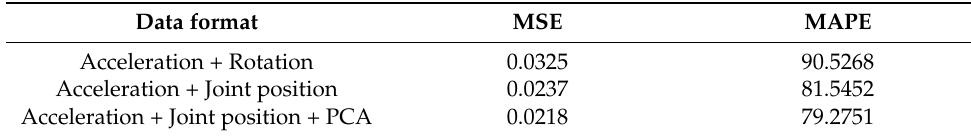
Table 3. Effect of the data format on results.